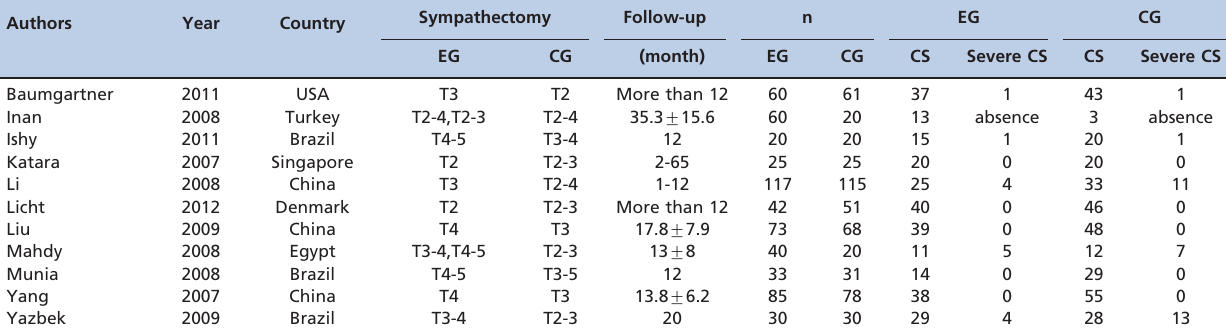
Table 1 - Description of the Included